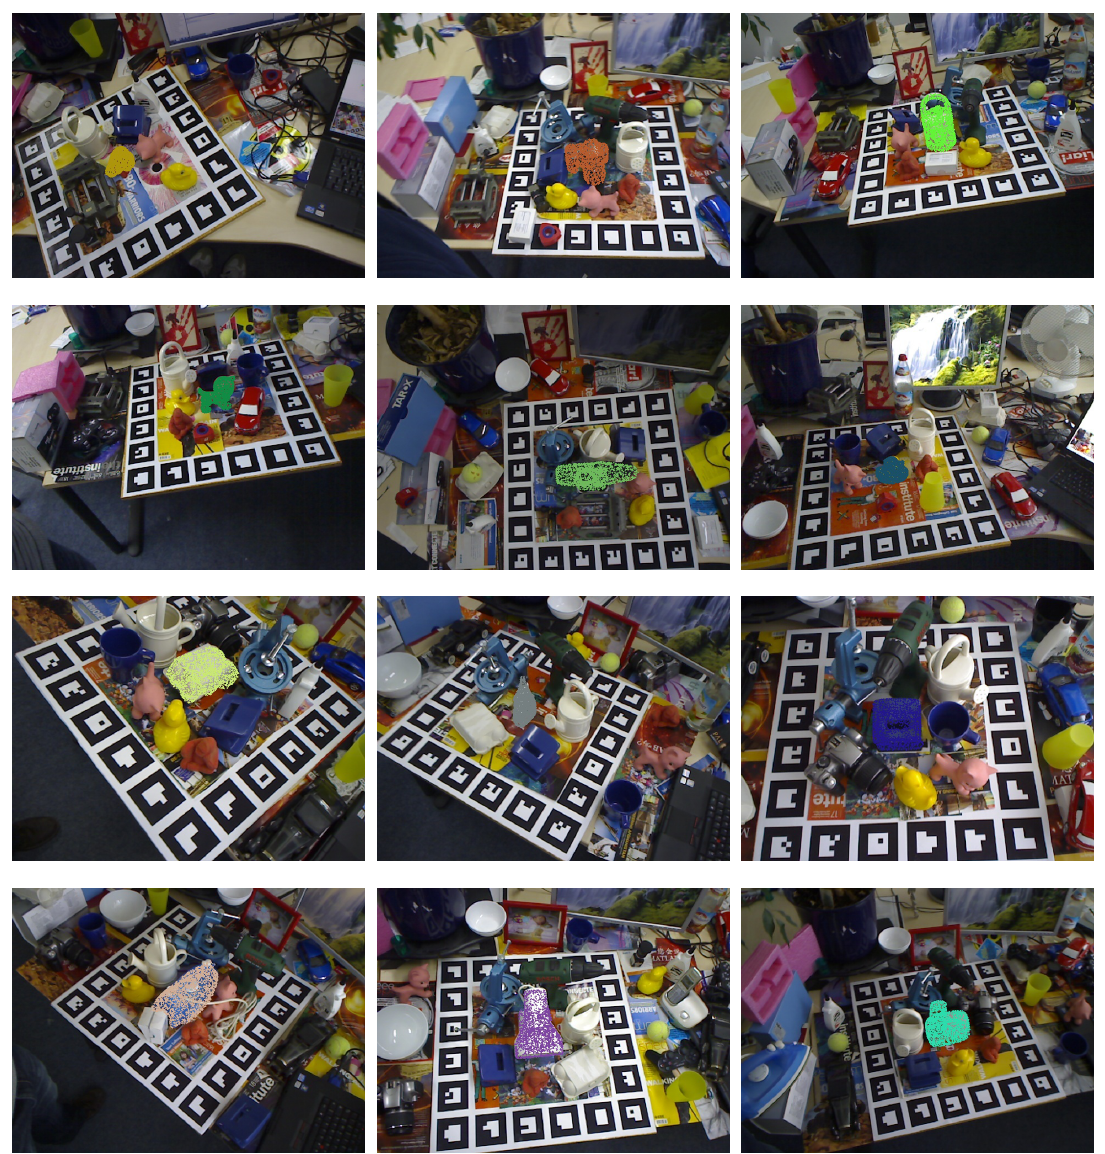
Figure 4. Some visual results of the Linemod